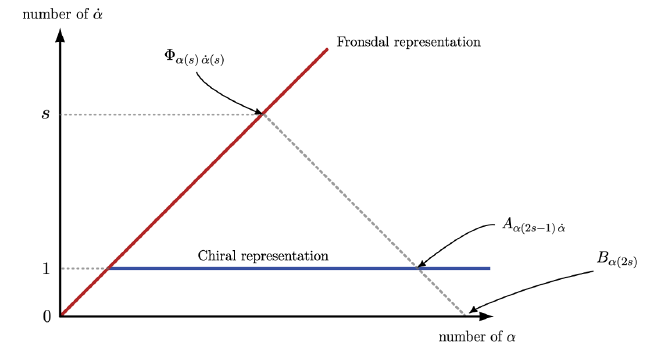
Figure 1 . A spin- s gauge field in two different representations: Fronsdal (red) vs chiral (blue) [1]. Here, m is the number of derivatives in each cubic vertex and p α ˙ α